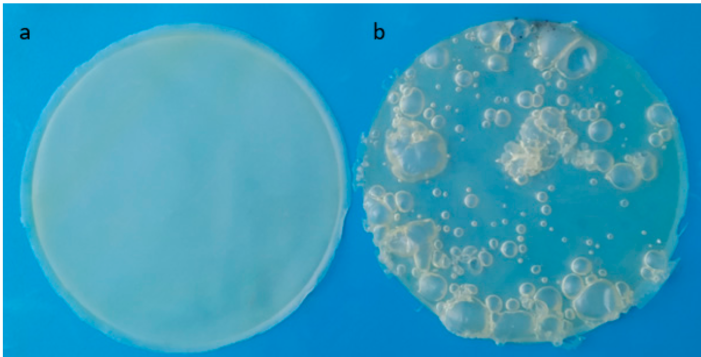
Figure 11. Picture of polyurethane elastomer ( a ) and a sample with the same, but poorly dehydrated substrates ( b